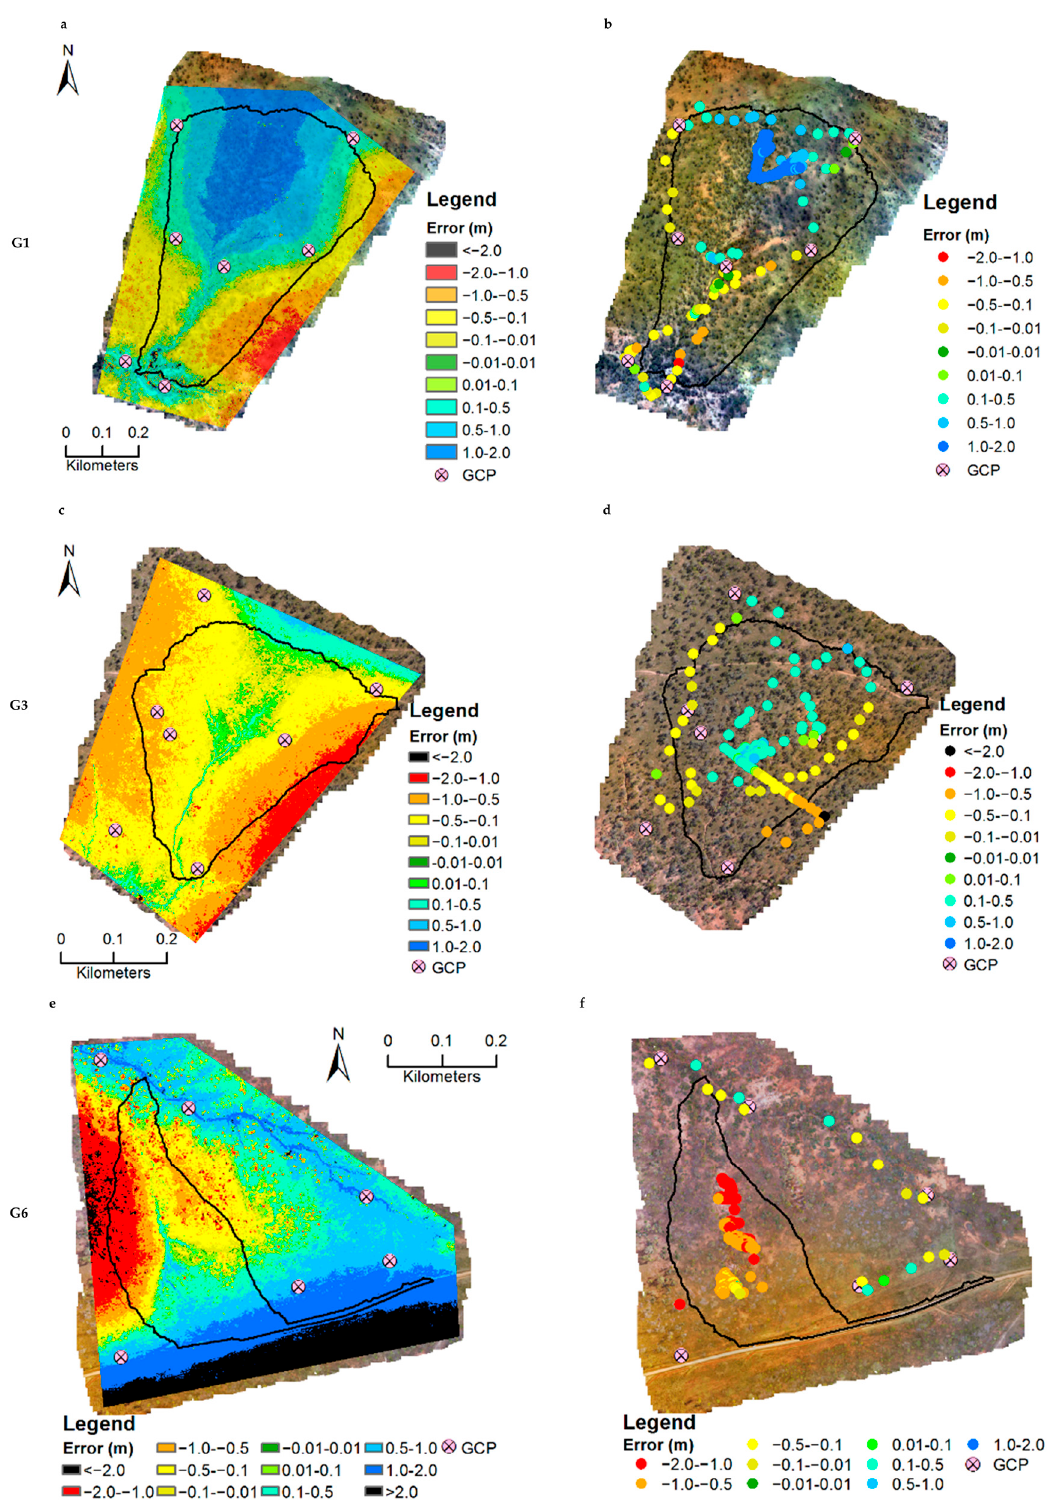
Figure 6. Map showing the difference between the airborne LiDAR DEM and the UAV DSM for ( a ) G1; ( c ) G3; and ( e ) G6 across the hillslope sites. Map showing the difference in elevation between RTK validation points and the UAV DSM for ( b ) G1; ( d ) G3; and ( f ) G6. Positive error values indicate the DSM is lower than the RTK validation point, while negative error values indicate that the DSM is higher than the RTK validation point.